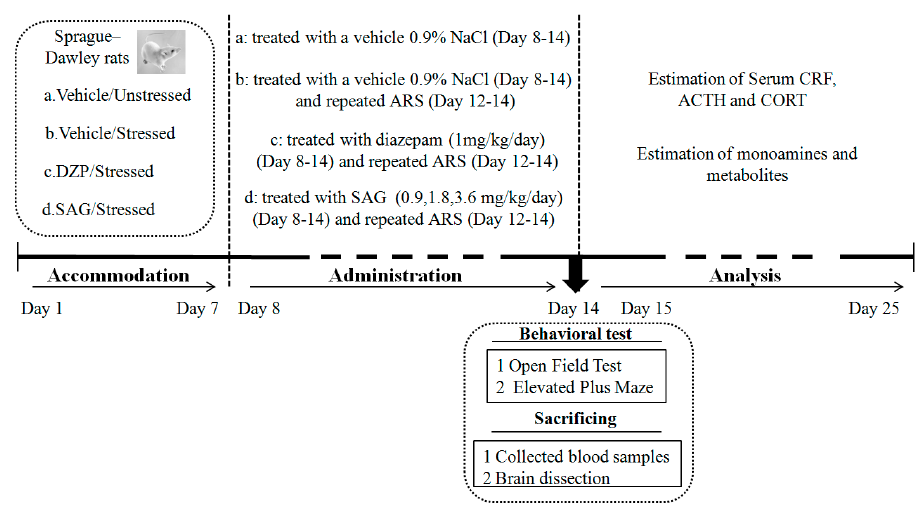
Figure 6. Experimental groups and procedure.